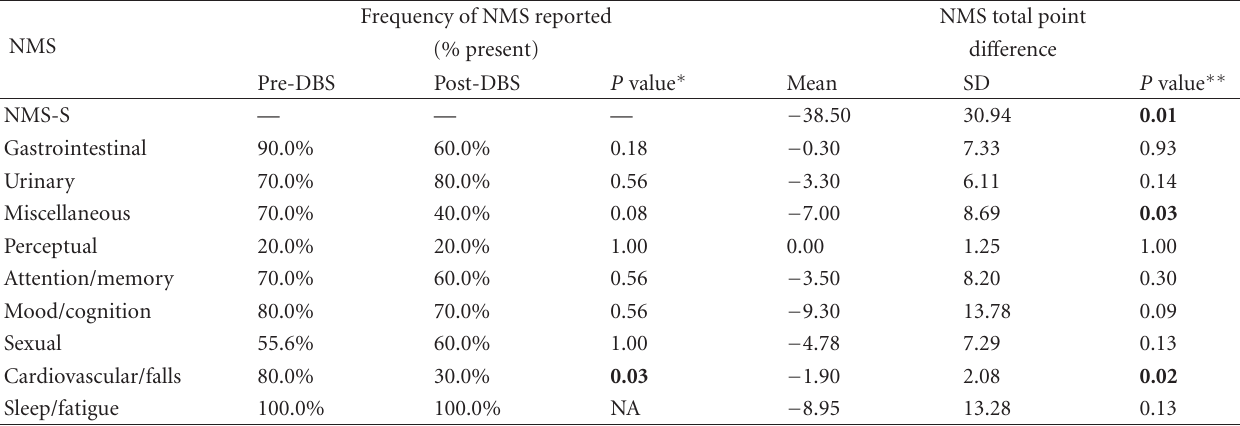
Table 2: Changes in nonmotor symptoms (NMS) scale. The left-sided group shows prepost-DBS change in prevalence of NMS symptoms. The right-sided group shows changes in NMS score as a di ff erence in total score. Improvements of NMS scores pre-post deep brain stimulation surgery were significant ( P = 0 . 01). Mean scores in miscellaneous symptoms ( P = 0 . 03) as well as cardiovascular/falls ( P = 0 . 02) symptoms had significant improvement. Prevalence of CV/falls was also significantly di ff erent between pre- and